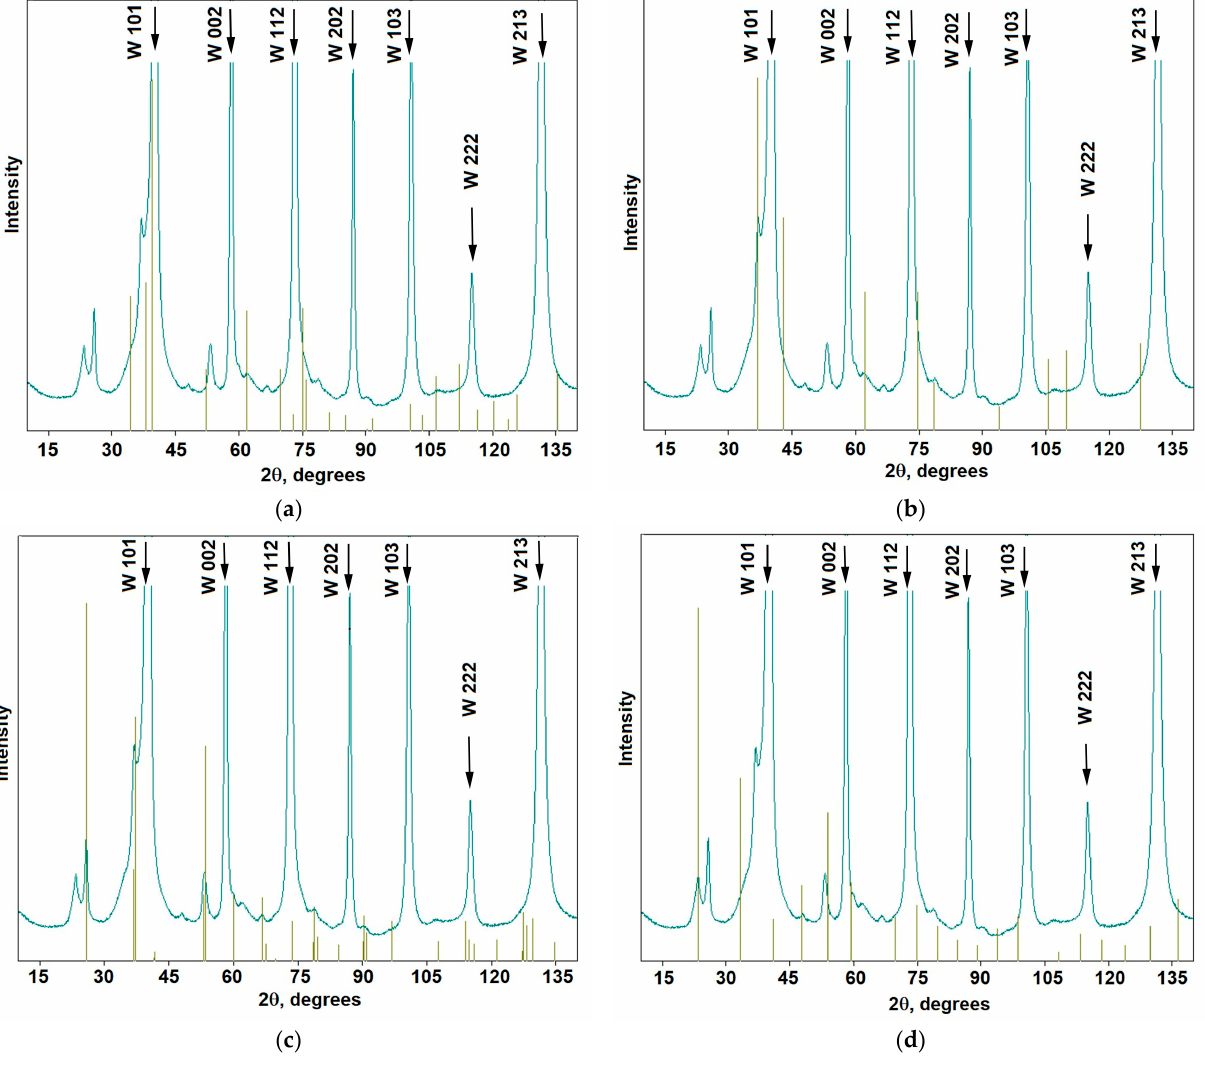
Figure 8. The X-ray diffraction pattern of the «tungsten + nanodiamonds» composite after heating up to 720 °C; tungsten peaks are shown with arrows, stick-diagrams show: ( a ) W 2 C, ( b ) WC 0.82 , ( c ) WO 2 , ( d ) WO 3.